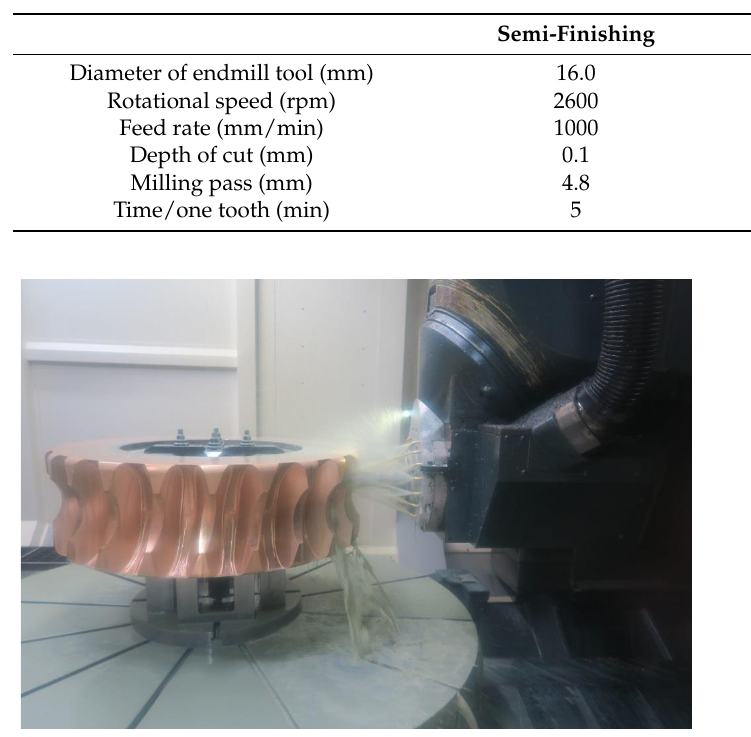
Figure 10. Manufacturing of worm wheel on universal CNC machine tool. Table 3. Cutting conditions for semi-finishing and finishing operation in manufacturing of worm wheel.